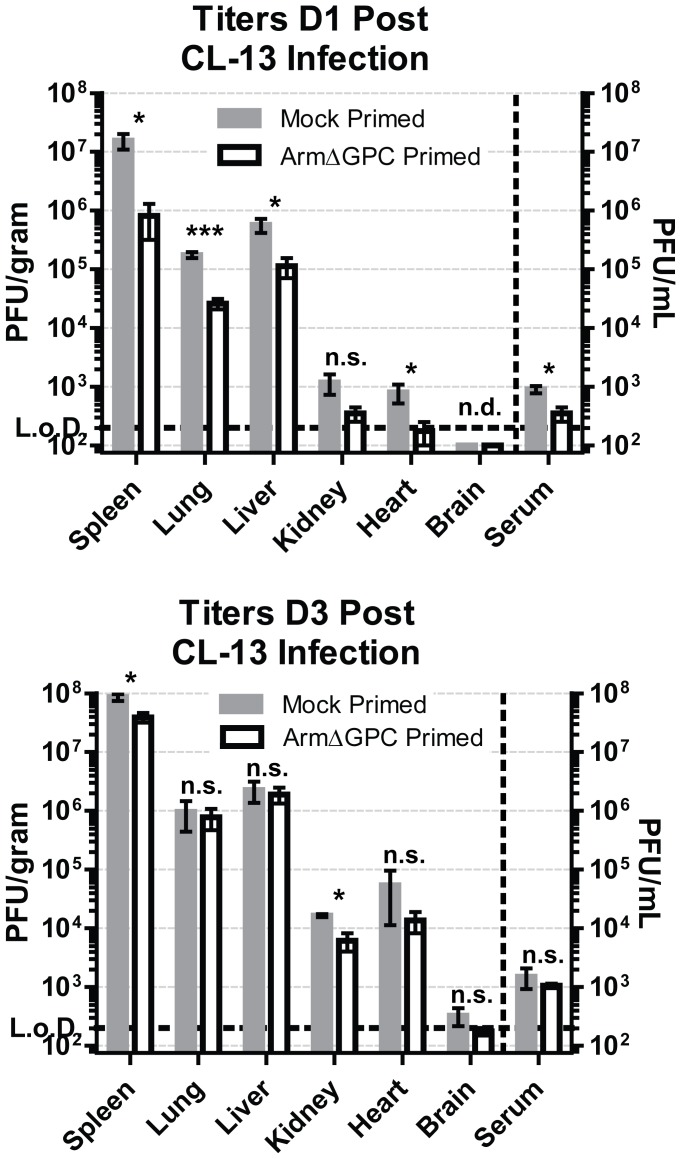
Kinetics of viral propagation at days 1 and 3 after Cl13 infection.C57Bl6/J mice (n = 4/group) were mock (PBS) primed or ArmΔGPC (2×106,i.v.) primed and 10 hours later infected with Cl13 (2×106,i.v.)). Organs were harvested at 24 (top panel) and 72 (bottom panel) hours post-infection and homogenates prepared in RPMI containing 10% FBS. Virus titers in clarified homogenates were determined as in Fig. 1. Statistical analysis was done using t-tests of log transformed values. NS, not significant; ND, none detected; *p<0.05; **p<0.005; **p<0.0005. Graphs are representative of three independent experiments.